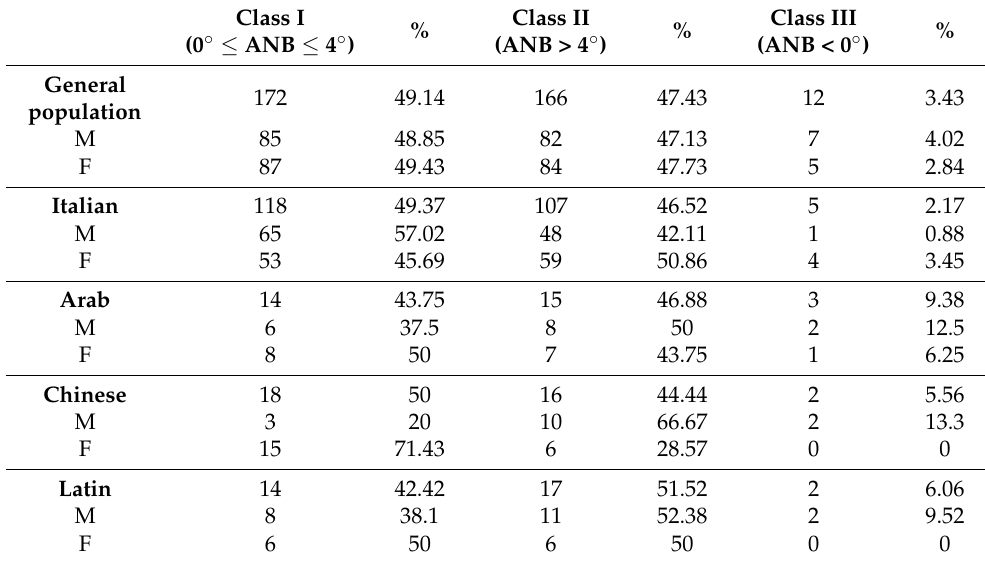
Table 2. Distribution of skeletal classes in the selected patient sample.